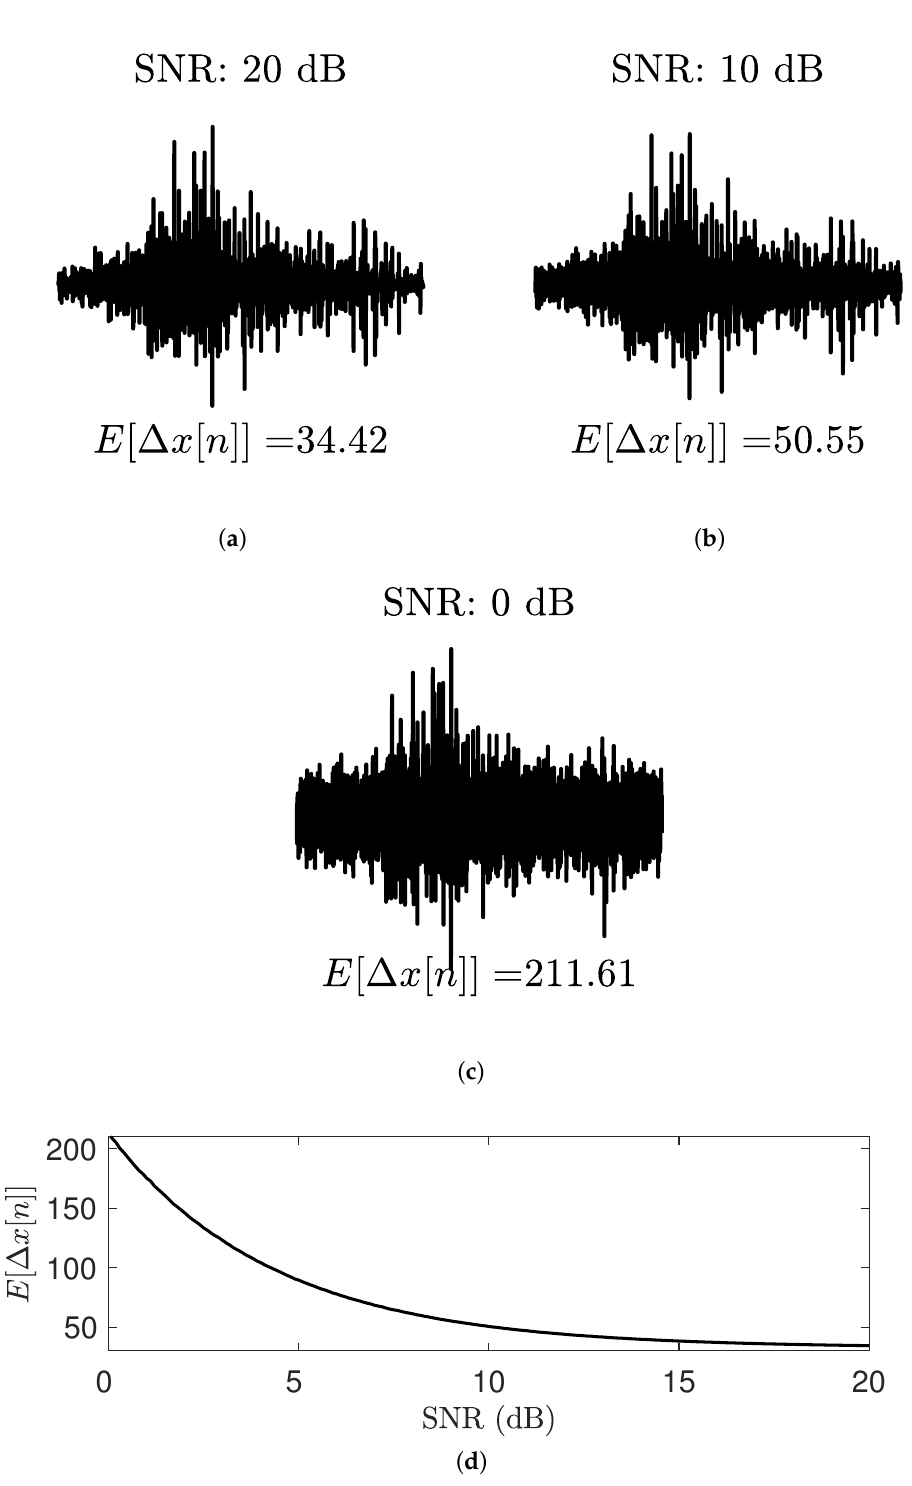
Figure 1. Change in raw data and feature related to signal-to-noise ratio (SNR). ( a – c ) Noisy signals with corresponding feature. SNR of each noisy signal is ( a ) 20, ( b ) 10, and ( c ) 0 dB. ( d ) Difference power based on